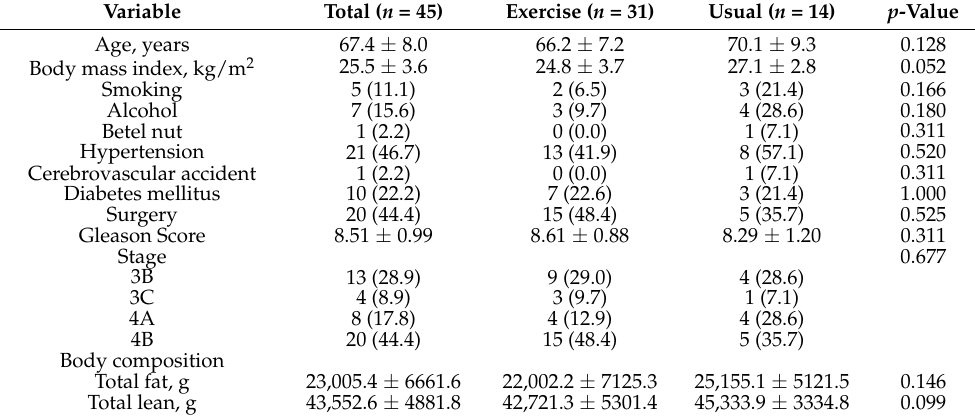
Table 1. Demographics of the exercise and usual